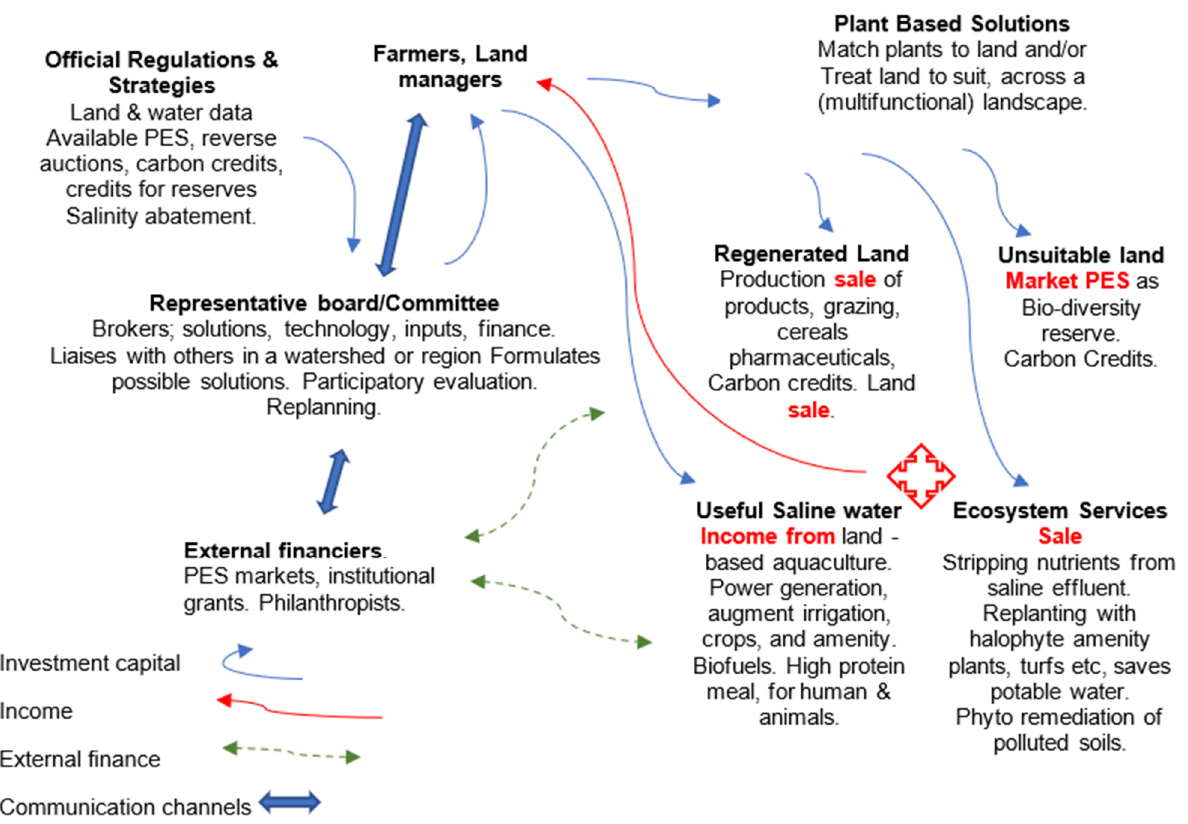
Figure 2. An approach to utilizing land and water degraded by salinity.